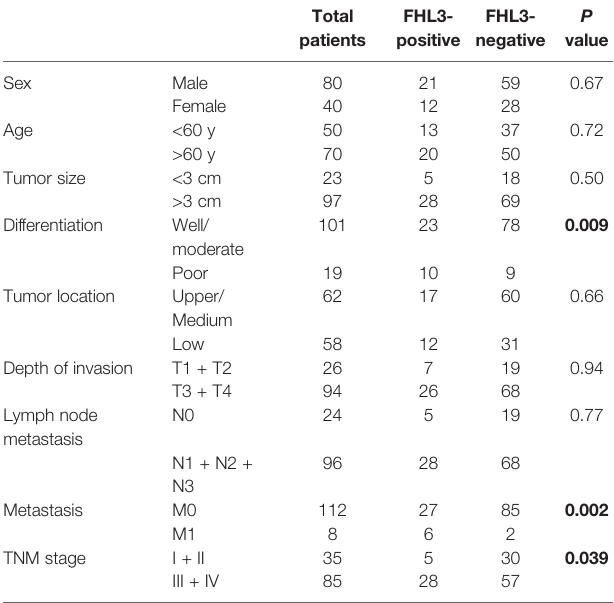
TABLE 1 | Association between clinicopathological parameters and FHL3 in 120 cases of gastric cancer.